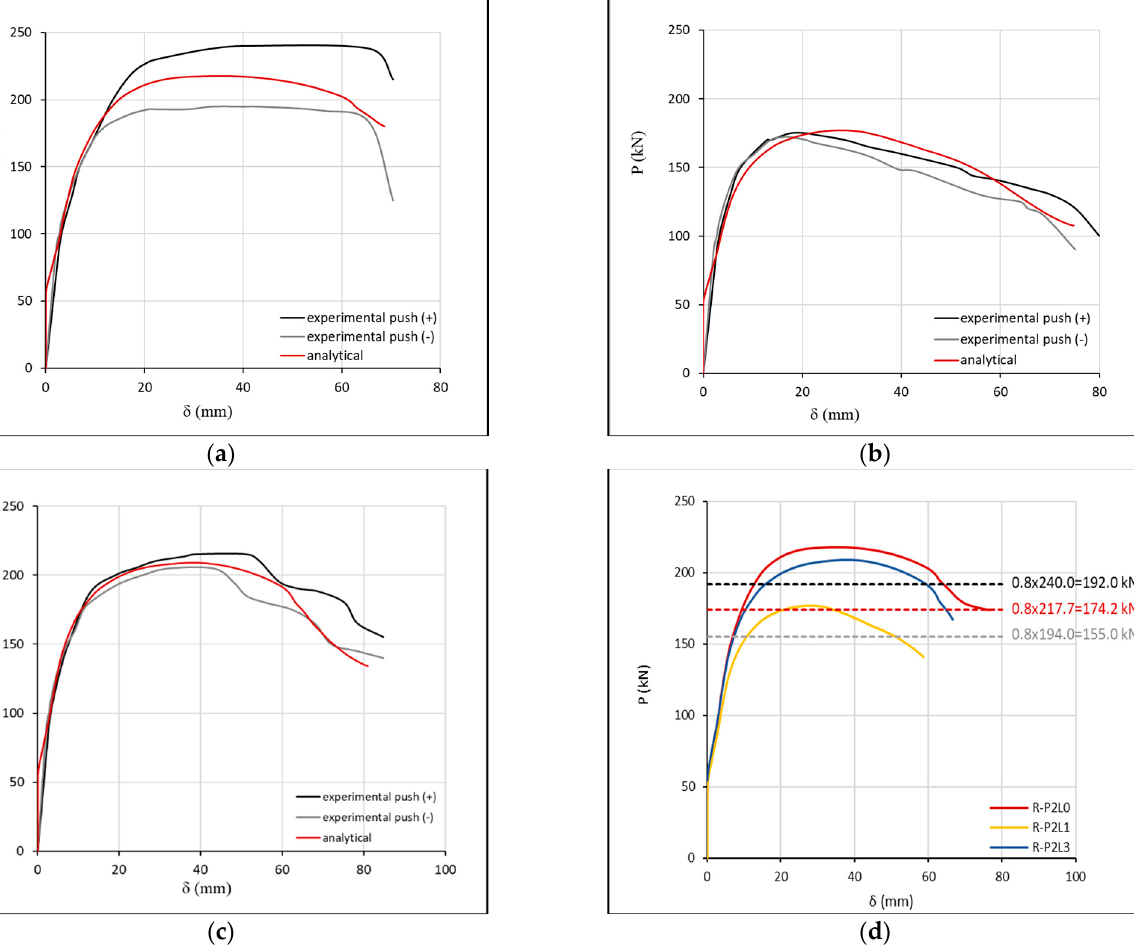
Figure 2. Comparative experimental (the envelope P- δ curves of the original experimental response) and analytical base